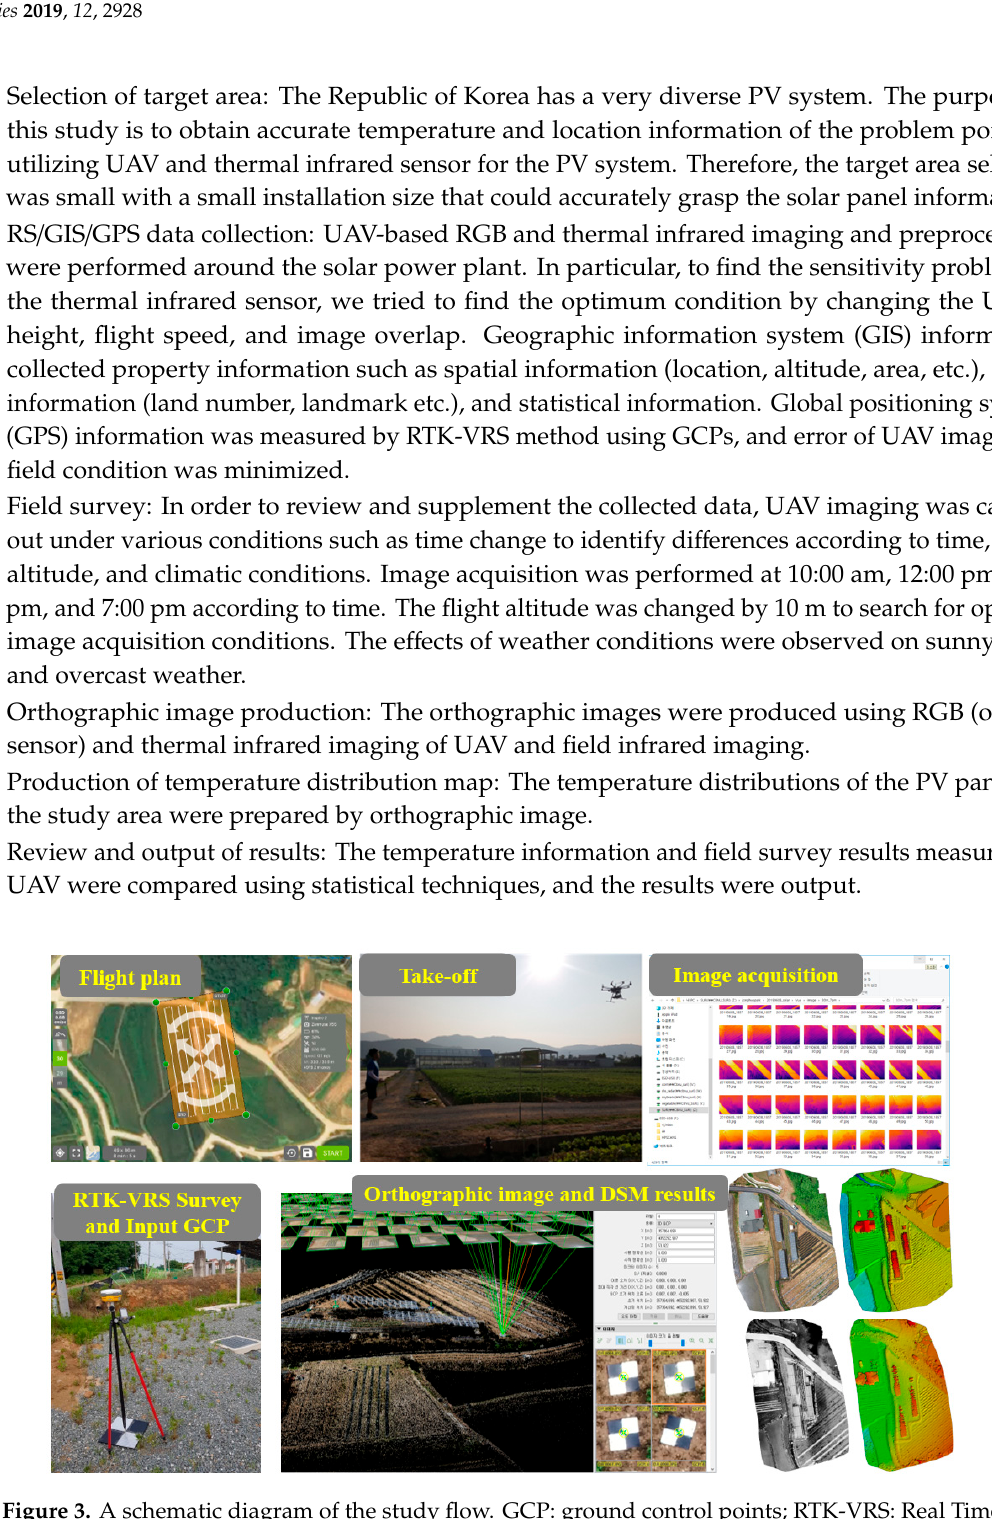
Figure 3. A schematic diagram of the study flow. GCP: ground control points; RTK-VRS: Real Time Kinematic-Virtual Reference Service; DSM: Digital Surface Model (DSM). Kinematic-Virtual Reference Service; DSM: Digital Surface Model